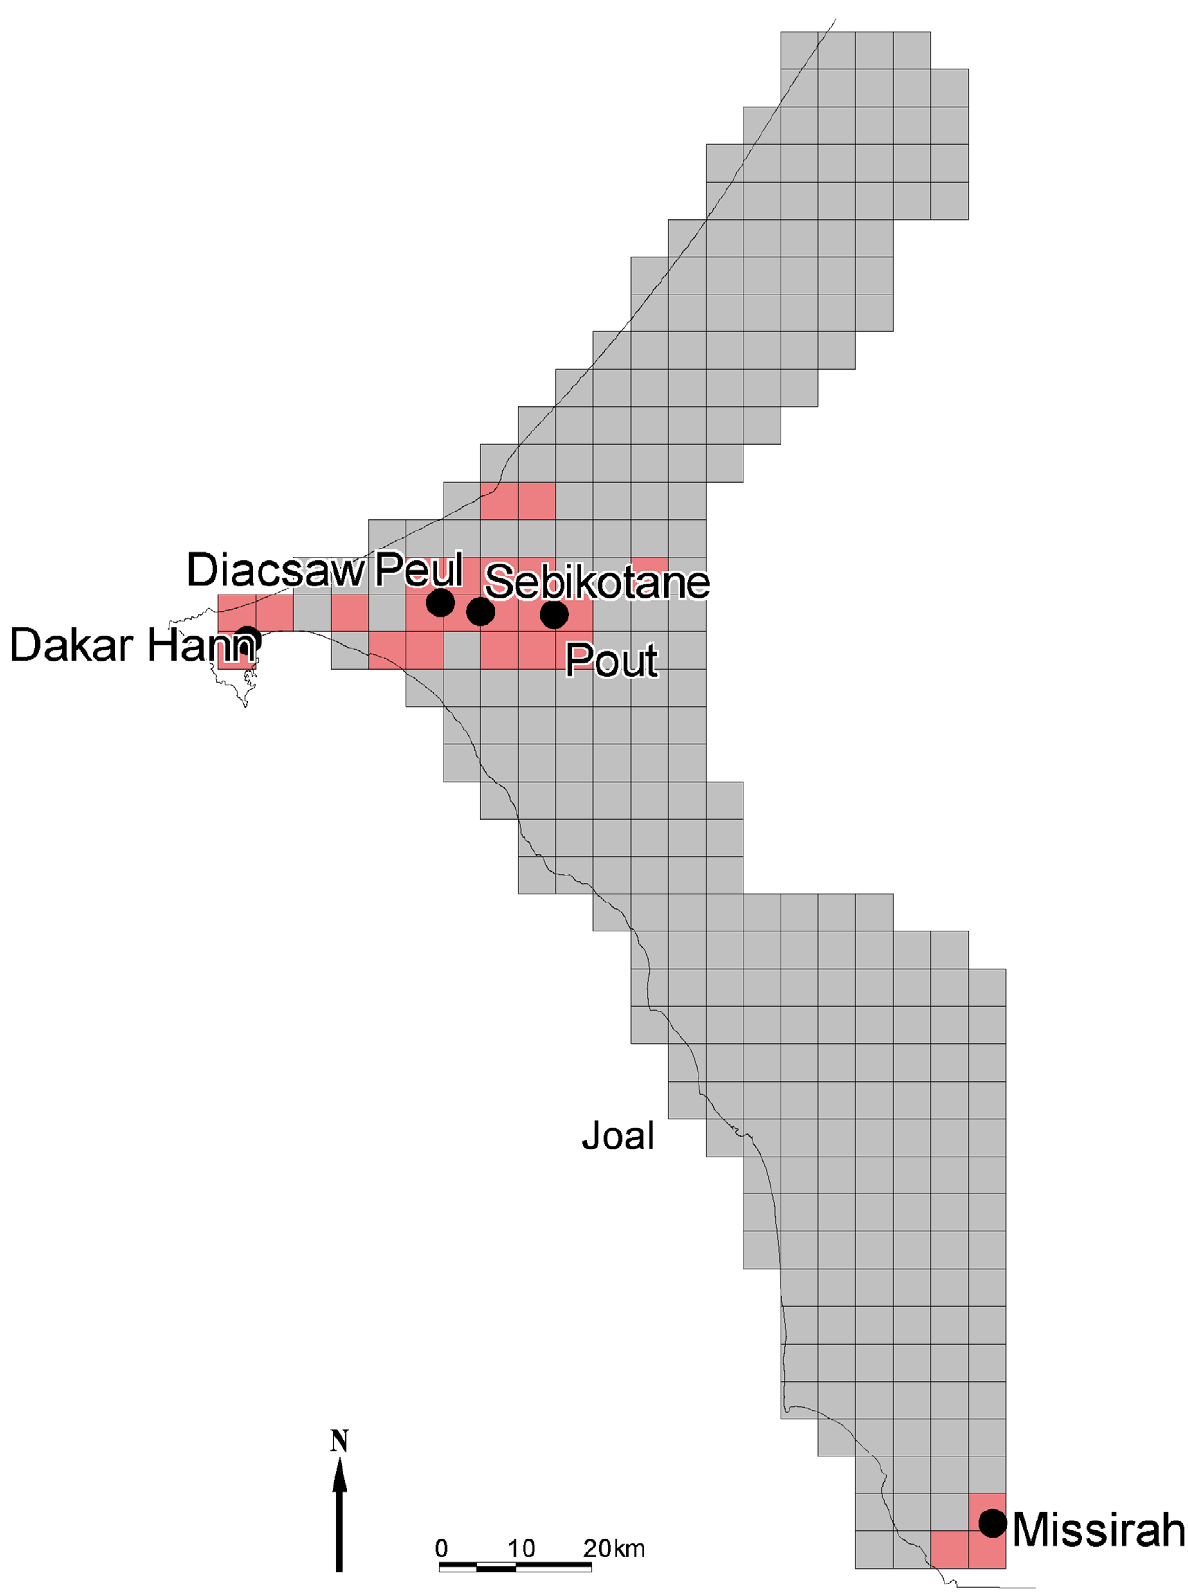
Figure 1. Geographic location of the study sites in Senegal. The study sites are located on the map, together with putative tsetse-infested area (red cells), according to the baseline entomological data collection of the tsetse eradication campaign in the Niayes of Senegal.